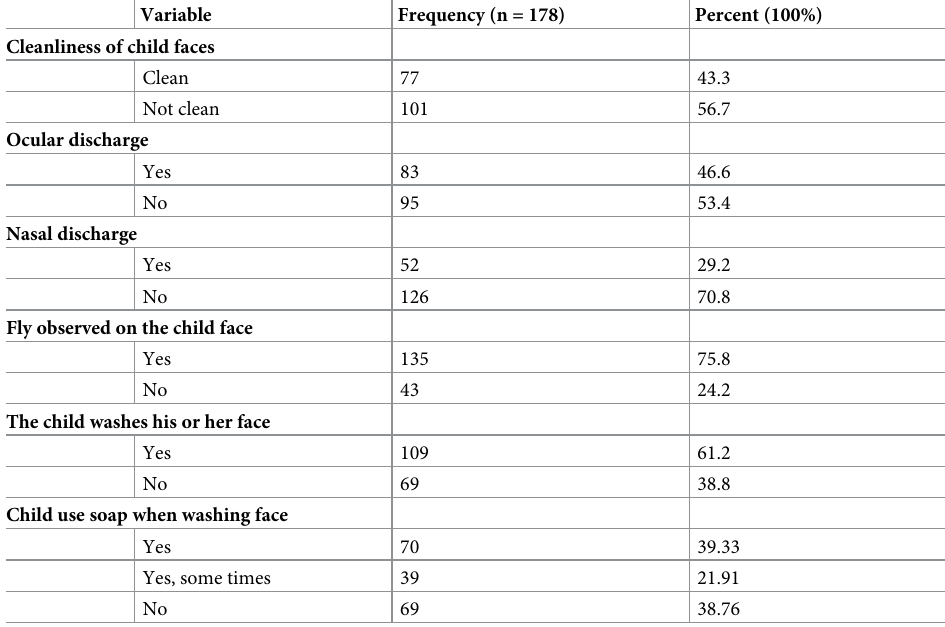
Table 5. Main proximate variables related to active trachoma among studied children of Arsi Negele Town, West Arsi Zone, Oromia, Southern Ethiopia, December, 2019.